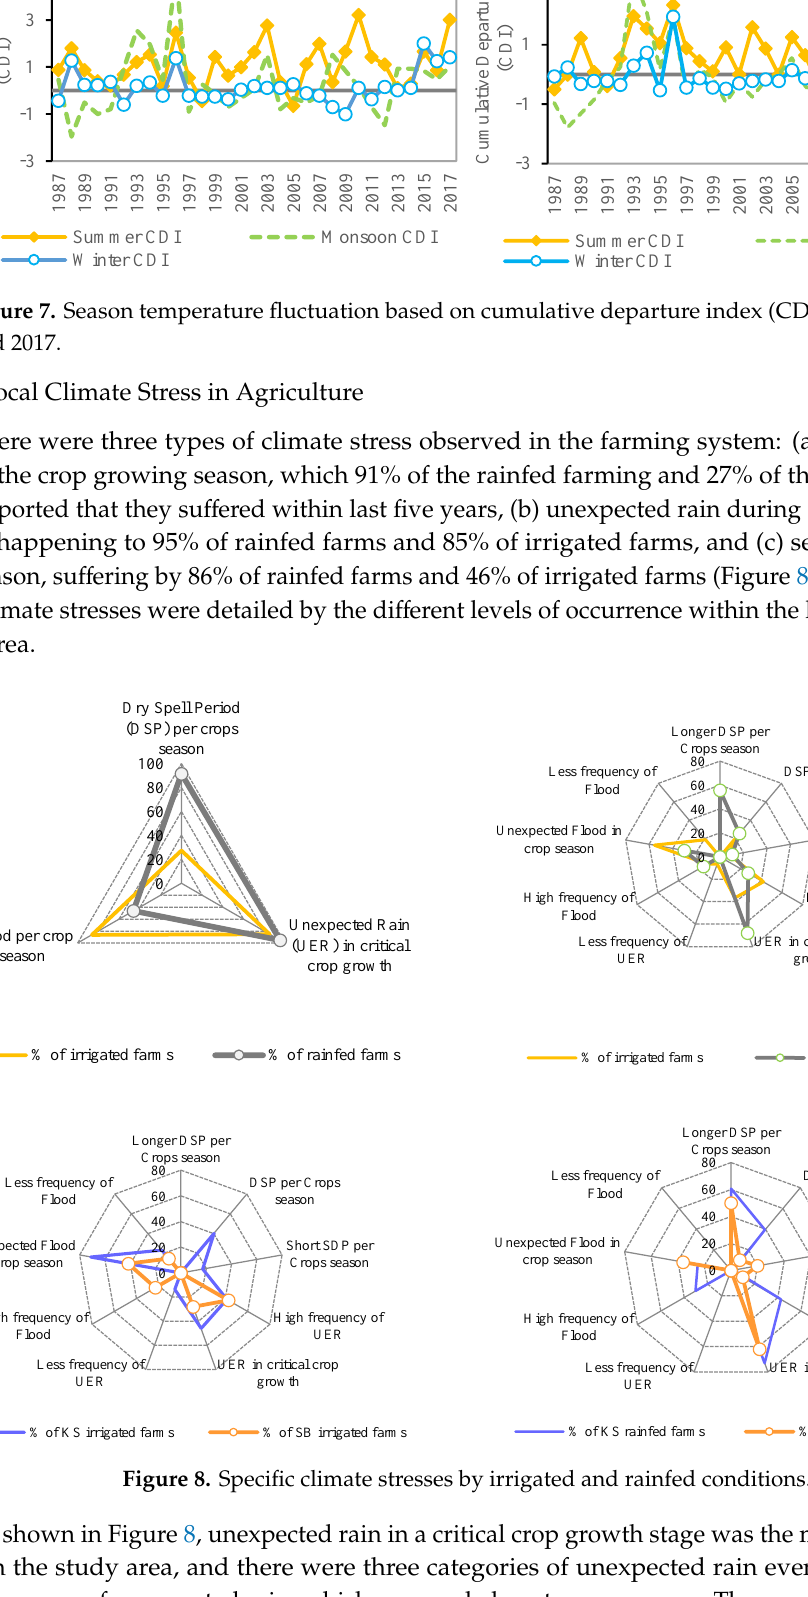
Figure 8. Specific climate stresses by irrigated and rainfed conditions.